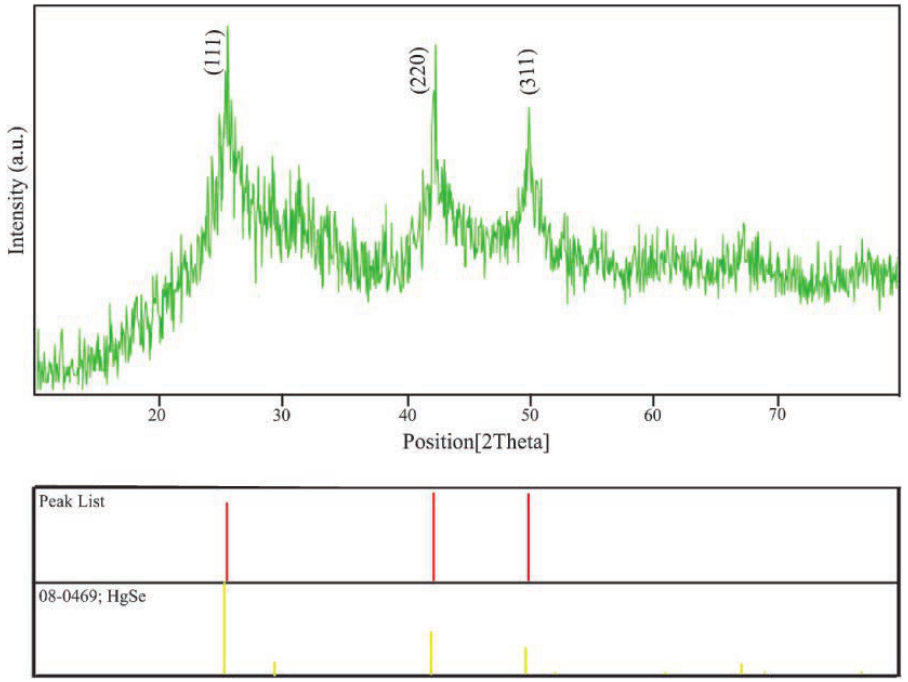
Fig. 1: XRD pattern of HgSe in presence of SDS for 30 min (no.